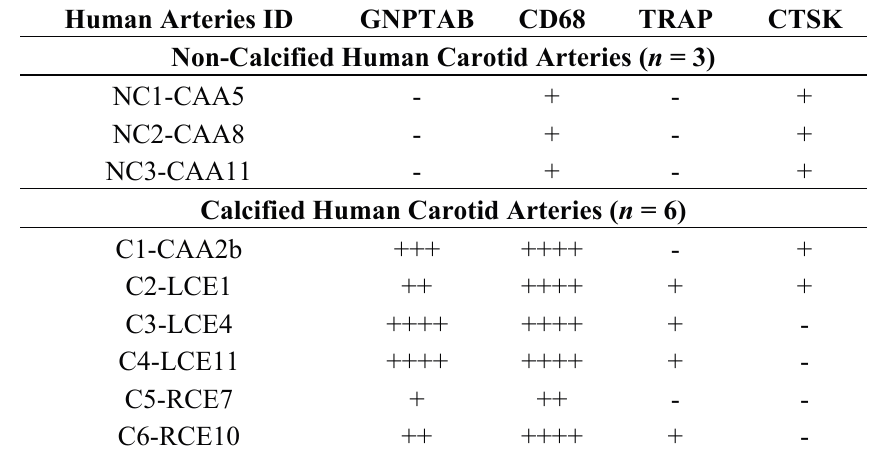
Table 1. An analysis for immunohistochemistry (IHC) studies including GNPTAB, CD68, TRAP, and CTSK expression in non-calcified ( n = 3) and calcified ( n = 6) human arteries. Our quantitative criteria for relative abundance of expression include “-” for 0% of positive cells; “+” for ≤ 25%; “++” for ≤ 50%; “+++” for ≤ 75%; and “++++” for ≤ 100%. C: calcified; NC: non-calcified; CAA: carotid artery from autopsy specimens; LCE: left carotid artery from endarterectomy specimens; RCE: right carotid artery from endarterectomy